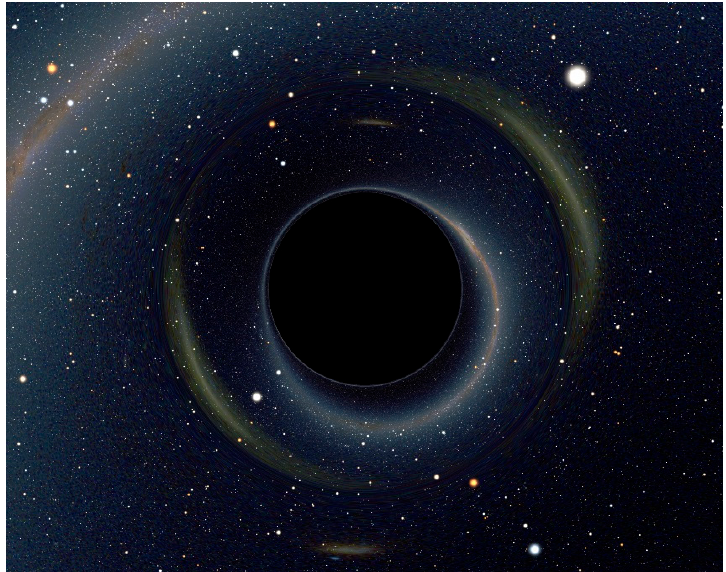
Figure 5. Gravitational lensing produced by a black hole in a direction almost centered on the Large Magellanic Cloud. Above it one easily notices the southernmost part of the Milky Way with, from left to right, Alpha and Beta Centauri, the Southern Cross. The brightest star close to the LMC is Canopus (seen twice). The second brightest star is Achernar, also seen twice. The two large arcs are the primary and secondary images of the LMC, the two smaller ones are those of the Small Magellanic Cloud. Courtesy Alain Riazuelo, CNRS/IAP.